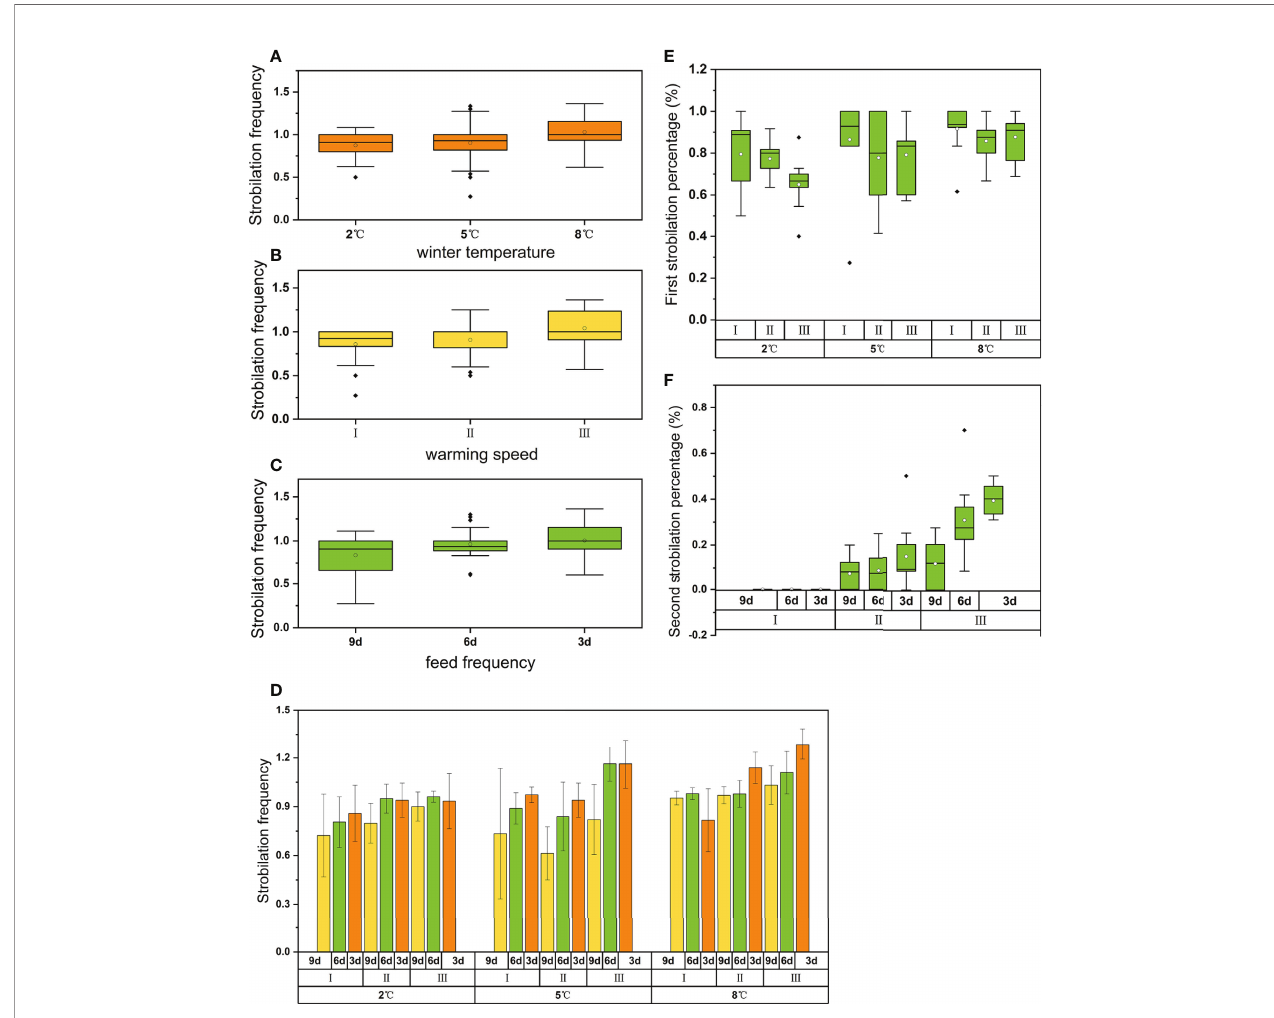
FIGURE 2 | Mean strobilation frequency at 3 winter temperatures (A) , 3 warming speeds (B) , and 3 feeding frequencies (C) . Strobilation frequency in all 27 treatments (D) . First strobilation percentage at 3 winter temperatures and 3 warming speeds (E) . Second strobilation percentage at 3 warming speeds and 3 feeding frequencies (F) . The solid line in each box represents the median and the hollow circle represents the mean. The extremities of the box denote the fi rst and the third quartile and the ends of vertical lines denote the range. Any points beyond the ends of vertical line are